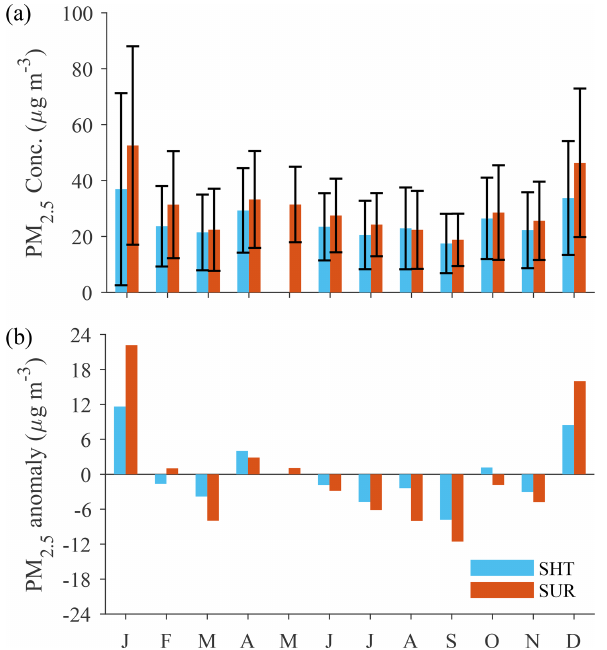
Figure 4. Monthly variations of (a) PM 2 . 5 concentrations (µgm − 3 ) at SHT and SUR and (b) PM 2 . 5 anomalies (µgm − 3 ) at SHT and SUR. The monthly averaged PM 2 . 5 in May at SHT is not presented because of low data collection efficiency (36%).